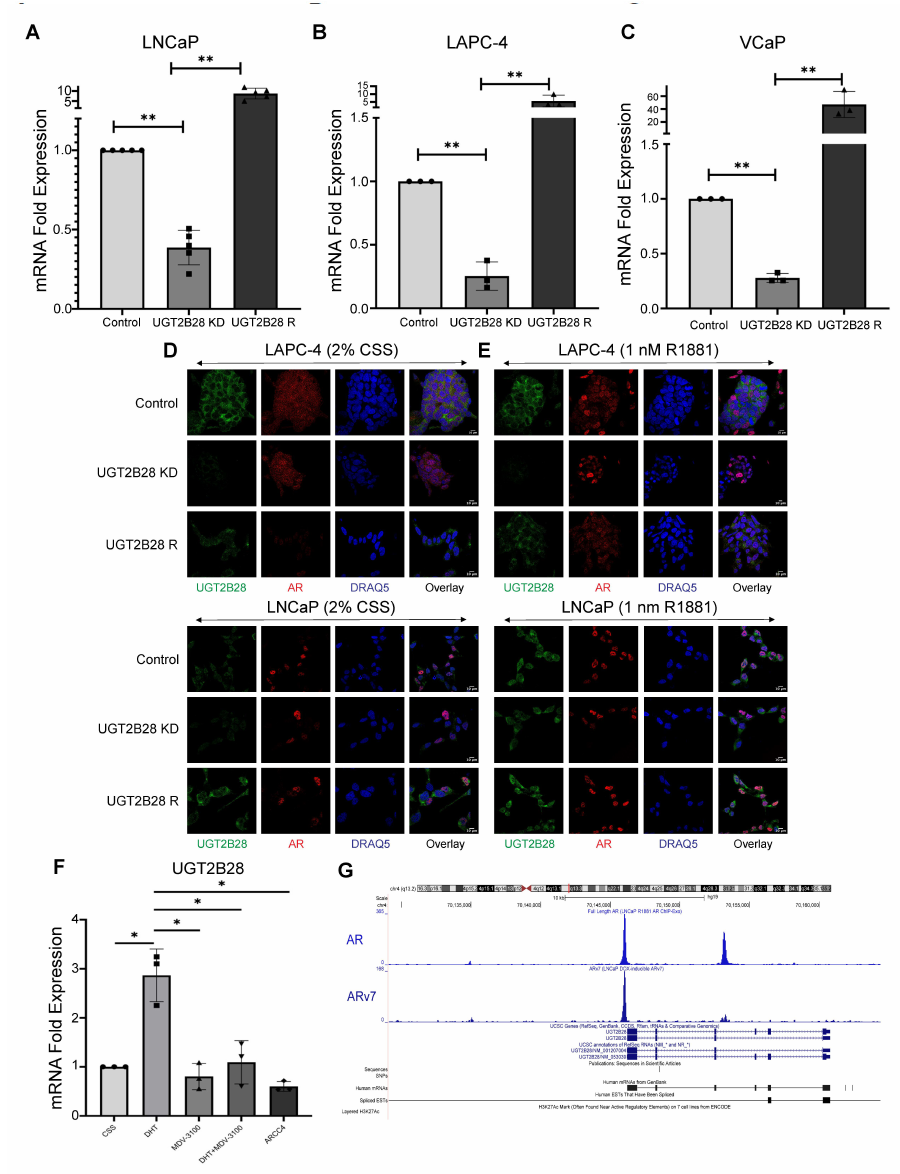
Figure 2. ( A – C ). qPCR verification of UGT2B28 transcript levels in ( A ) LNCaP, ( B ) LAPC-4 and ( C ) VCaP cells upon shRNA-mediated UGT2B28 knockdown (UGT2B28 KD) or re-expression rescue (UGT2B28 R), compared to scrambled controls (UGT2B28 NT, ** p < 0.001, n = 3/group/cell line). The data are represented as the mean + / − the standard deviation (SD). ( D ). Immunofluorescence images showing UGT2B28 and AR expression and their localization in LNCaP and LAPC-4 cells containing control (UGT2B28 NT), UGT2B28 KD, and re-expression rescue (UGT2B28 R) grown in charcoal-stripped serum (CSS). Scale bar = 10 µ m. ( E ). Same as in ( D ), but for LNCaP and LAPC-4 cells grown in 1 nM R1881. Scale bar = 10 µ m. ( F ). UGT2B28 transcript expression levels in LNCaP cells treated with 1 nM 5 α -dihydrotestosterone (DHT), 10 µ M MDV-3100, 1 nM DHT+10 µ M MDV-3100, and 300 nM ARCC4 for 24 h. The data are represented as the mean + / − the standard deviation (SD). * p < 0.01, n = 3. ( G ). ChIP-Exo of the UGT2B28 promoter region in LNCaP cells treated with 1 nM R1881 (full length AR binding, (top)) and LNCaP cells with doxycycline-induced AR-v7 (AR-v7 binding, (bottom)) reveal binding of AR and AR-v7,